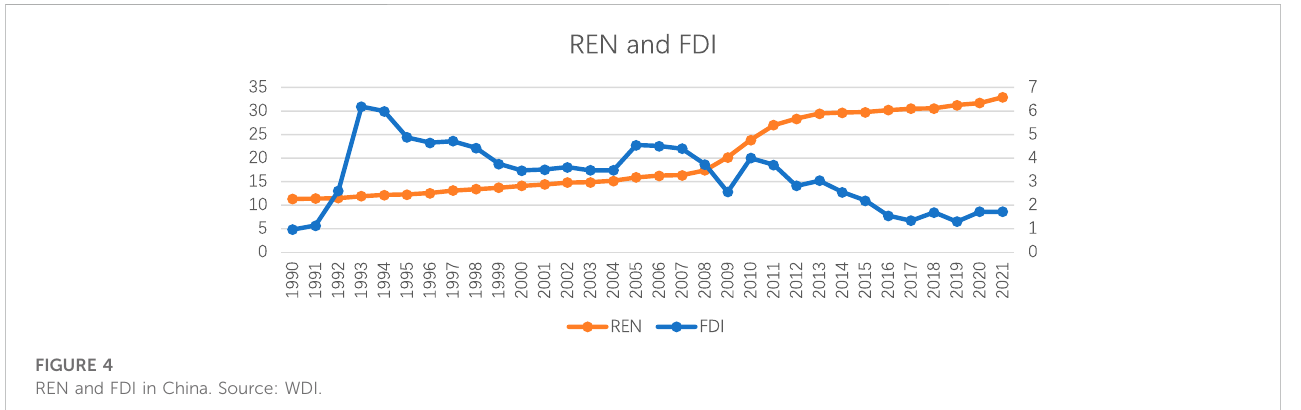
FIGURE 4 REN and FDI in China. Source: WDI.